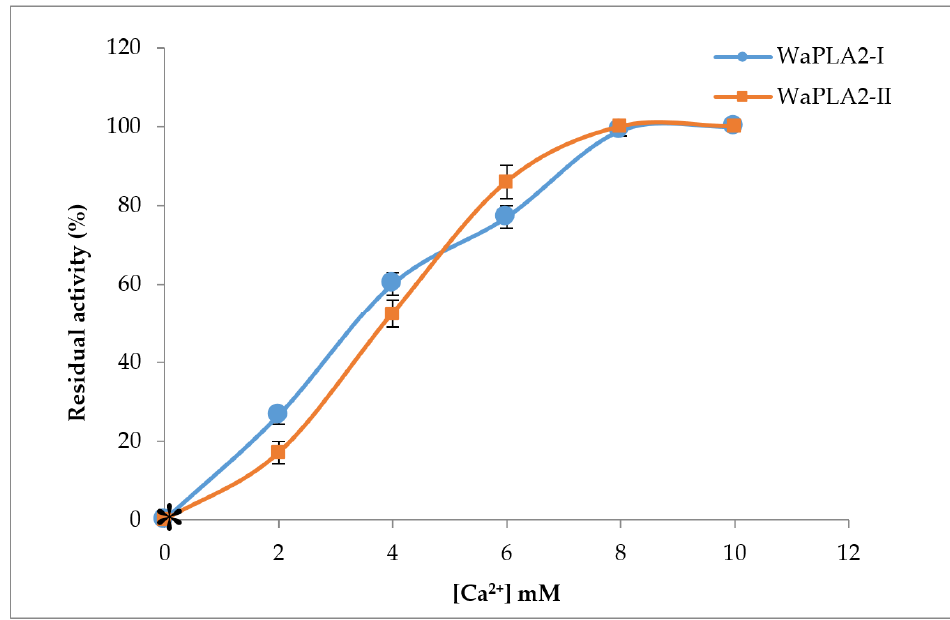
Figure 4. The effect of Ca 2+ concentrations on purified Wa PLA 2 -II and -I activities. Enzyme activity was measured at various concentrations of Ca 2+ (0–10 mM) using PC as the substrate at pH 9.5 and 55 °C for WaPLA 2 -II, and at 45 °C and pH 8.5 for Wa PLA 2 -IA in the presence of 4 mM NaTDC. The absence of phospholipase activity checked in the presence of 10 mM EGTA/EDTA and in the absence of CaCl 2 is indicated by a star symbol. The results represent the means of three independent experiments and expressed as the mean ± SD (n = 3).